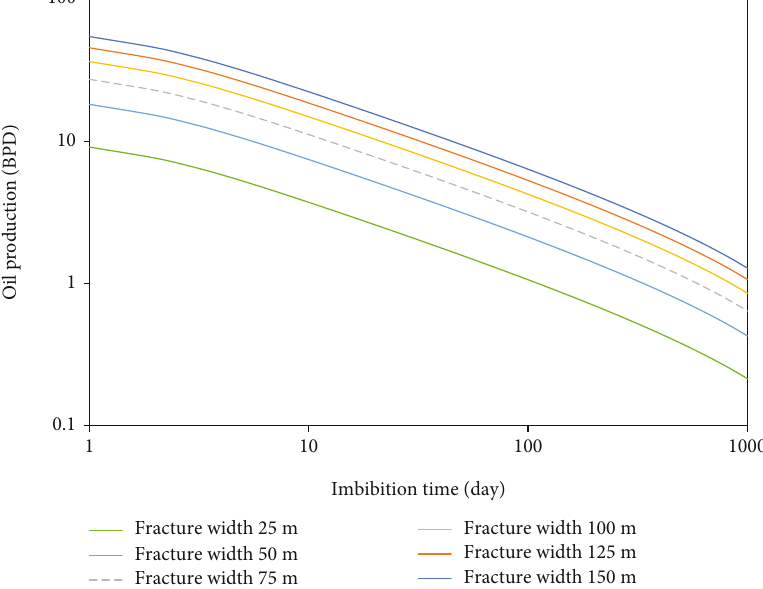
Figure 15: Relationship between the fracture width and oil